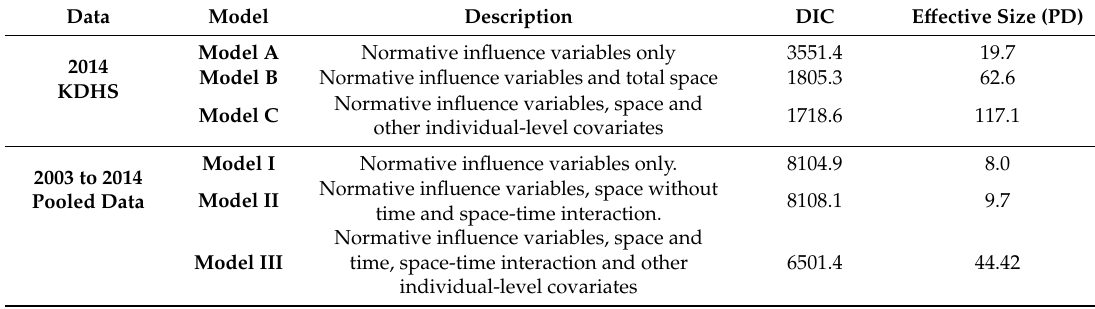
Table 2. Deviance information criterion (DIC) and e ff ective sample size (pD) from the three models fitted on the 2014 KDHS data and the combined 2003 to 2014